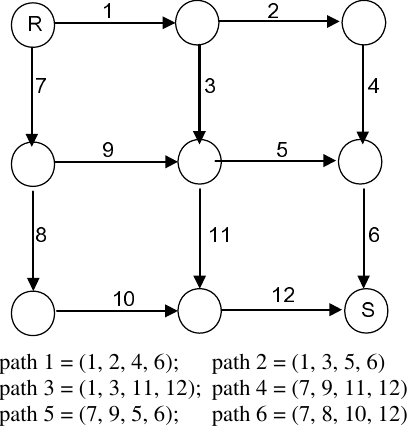
Fig 1 . Example network